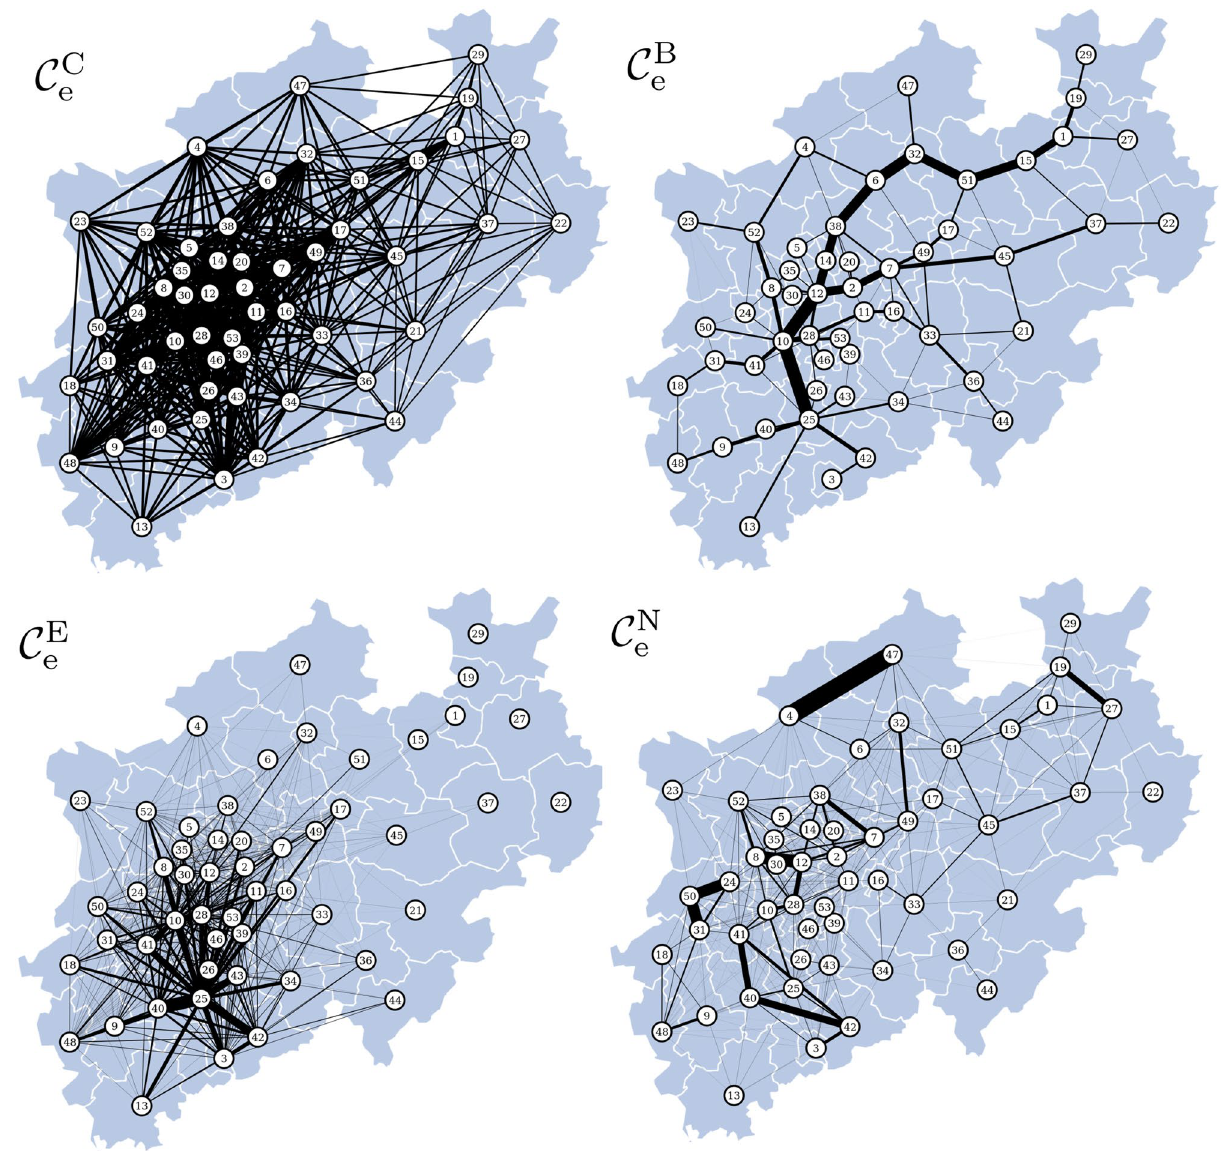
Figure 4. Key connections in the commuter traffic network of North Rhine-Westphalia (NRW). Connections identified with different edge centrality concepts (edge closeness centrality C C e ; edge eigenvector centrality C E e ; edge betweenness centrality C B e ; nearest-neighbor edge centrality C N e ). Numbered vertices represent the rural and urban districts in NRW and edges indicate commuter traffic between them. Edge importance is encoded as line